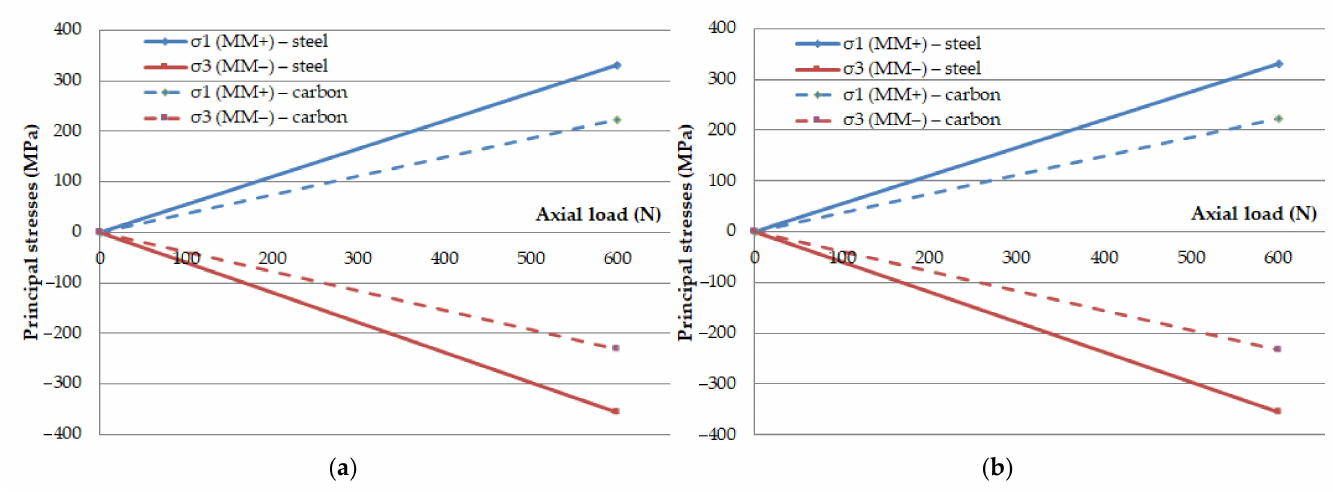
Figure 11. Values of the principal stresses due to axial load, ( a ) B50, ( b ) C50. Measurement results of the displacements for the models of the bone segments in the fracture zone (B50—Carbon) are shown in Figure 12. Displacements are monitored in directions x and z . Other results, obtained for the remaining fixation device configurations and specific frame material, are shown in Table 2.